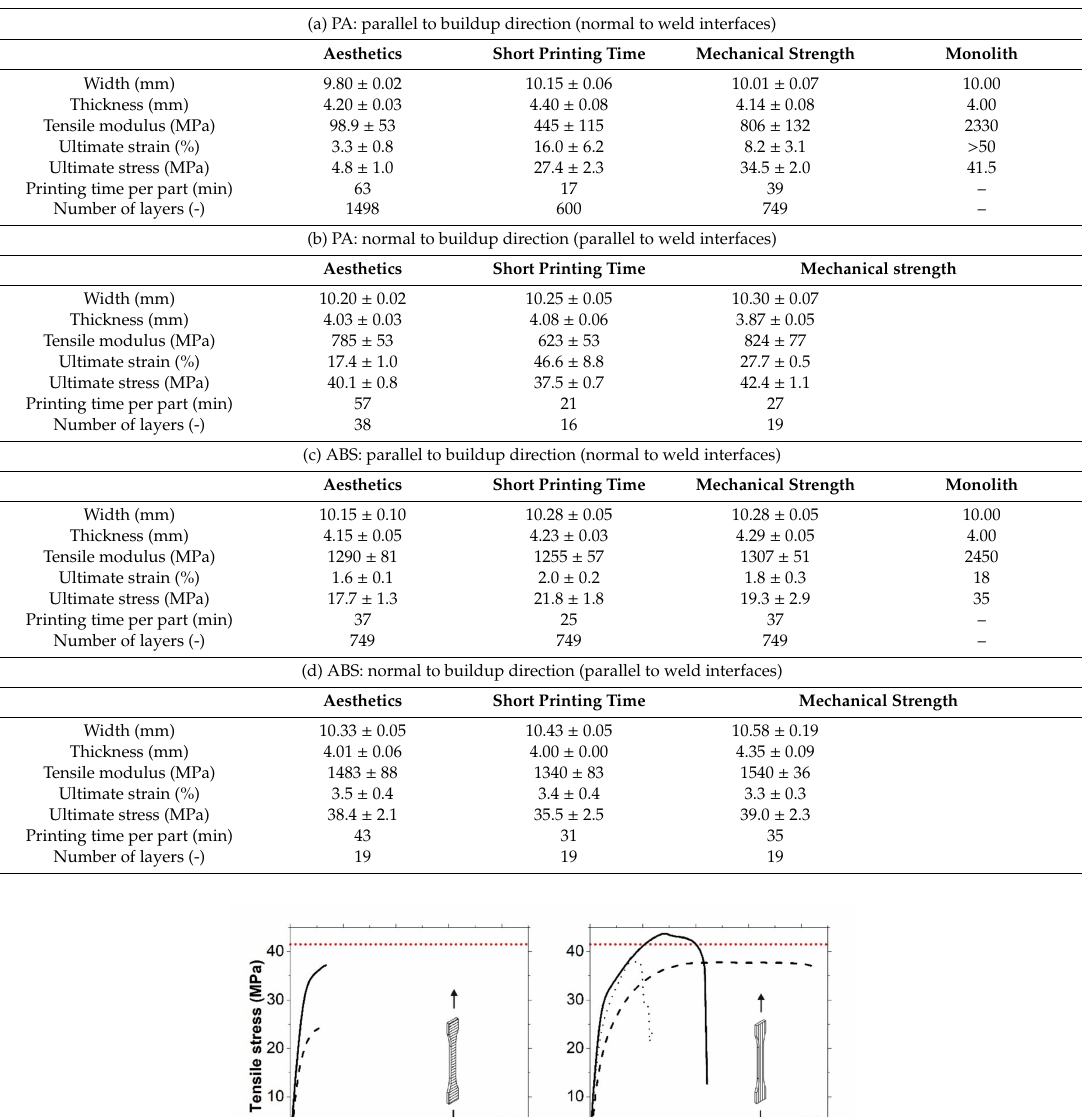
Table 3. Results of tension tests of standard tensile bars 3D-printed with PA (a,b) and ABS (c,d), using the optimized PP values. The loading direction is parallel (a,c) and normal (b,d) to the buildup direction. The number of layers and the average printing time per single part are shown too. The mechanical properties of the injection-molded parts are listed in the column “Monolith” (as reported in the manufacturer-supplied technical documentation sheets).